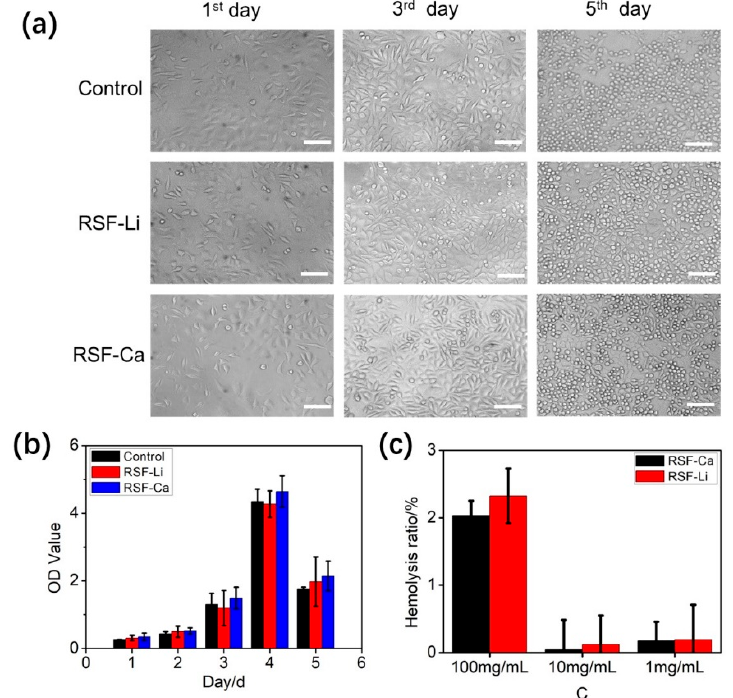
Figure 5. The cytocompatibility and hemolysis of the RSF. ( a ) The cellular morphology and ( b ) cell survival rate of mouse L929 cells in the control medium and the RSF-added media. Cellular morphology was observed on the first day, the third day, and the fifth day. ( c ) The hemolysis rate of the RSF that directly contacted red blood cells in a solution state. The scale bars in ( a ) represent 100 µm.